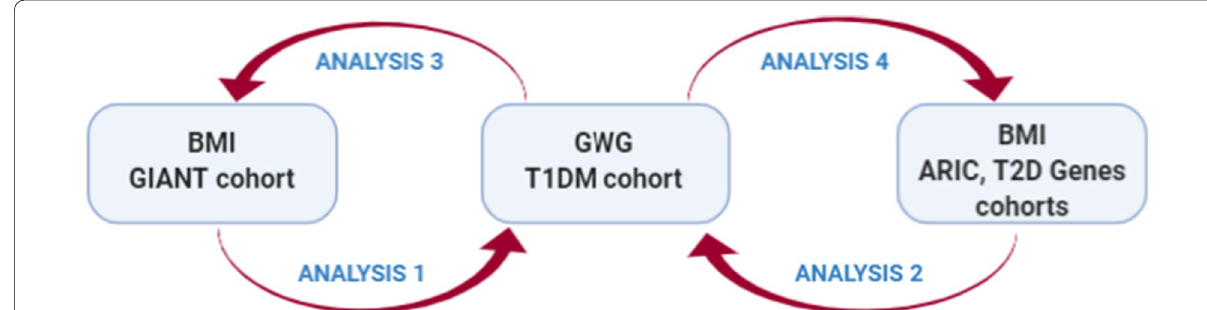
Fig. 1 The scheme of the workflow. TWAS analyses to find genes associated with BMI in the general cohort (GIANT) and two diabetic cohorts (T2D‑GENES, ARIC) as well as with GWG in the T1DM cohort, followed by variant associations between the two